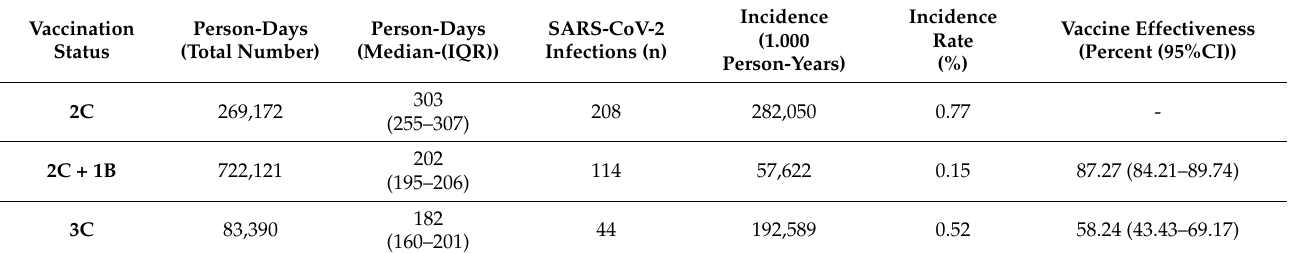
Table 3. The effectiveness of the third dose of CoronaVac or BNT162b2 following a two-dose Coron- aVac regimen in preventing COVID-19 cases after 14 days from second or third